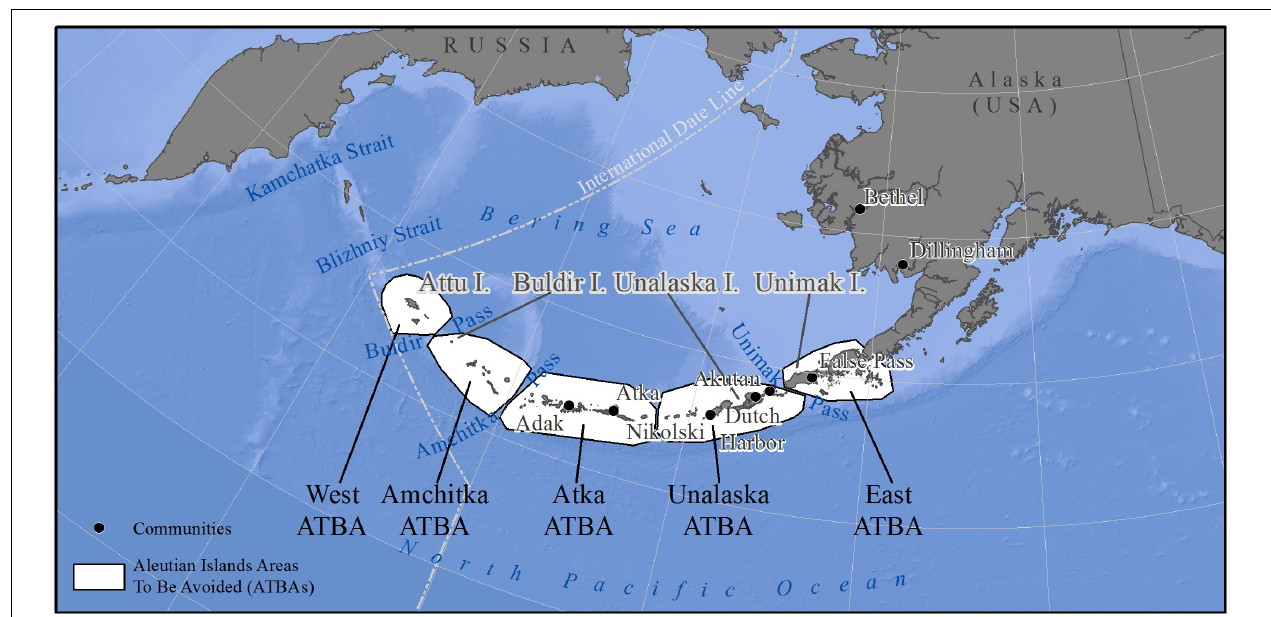
FIGURE 2 | Aleutian Islands Areas To Be Avoided (ATBAs), as implemented by the International Maritime Organization in 2016. These five ATBAs (white polygons) were designated to reduce the risk of marine casualty and designate routes through approved passes in the Aleutian